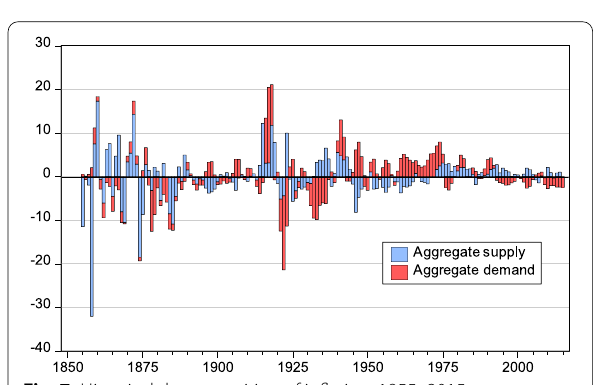
Fig. 7 Historical decomposition of inflation,